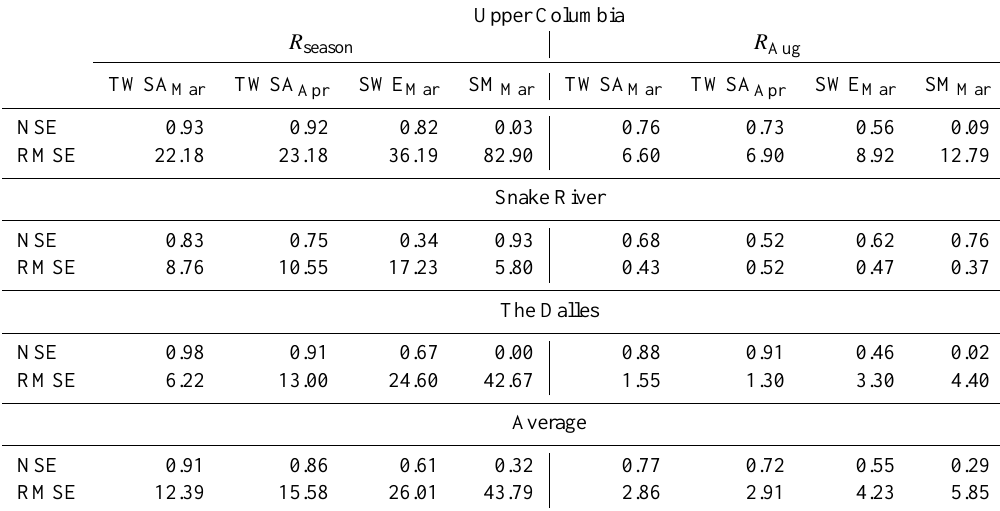
Table 2. Comparison of performance metrics from applying all 9 water years of GRACE TWSA data, model-derived snow (SWE), and soil moisture (SM) products in predicting seasonal ( R season ) and August ( R Aug ) runoff by watershed. Average values for the three basins are also provided. RMSE values are in mm. R 2 values are the same as NSE for this linear regression. Complete results can be found in Appendix Table A4.